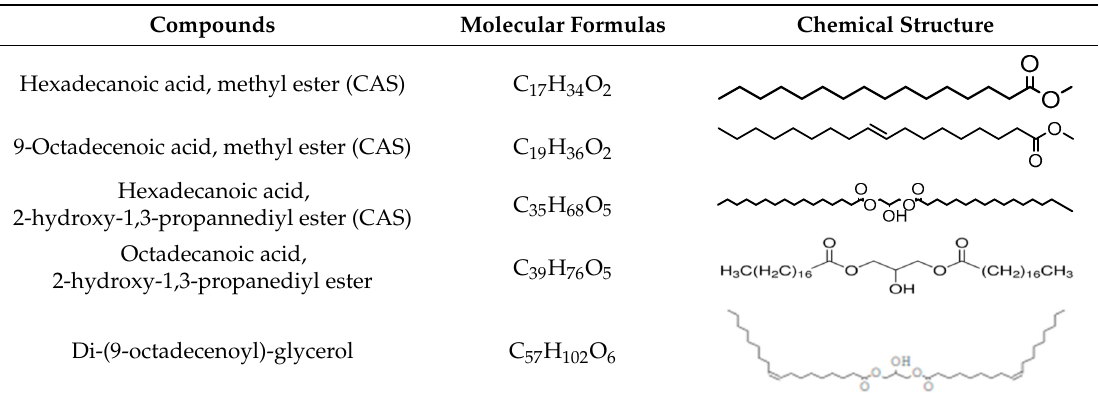
Table 4. Biodiesel characteristic using the HAP/KIO 3 catalyst.